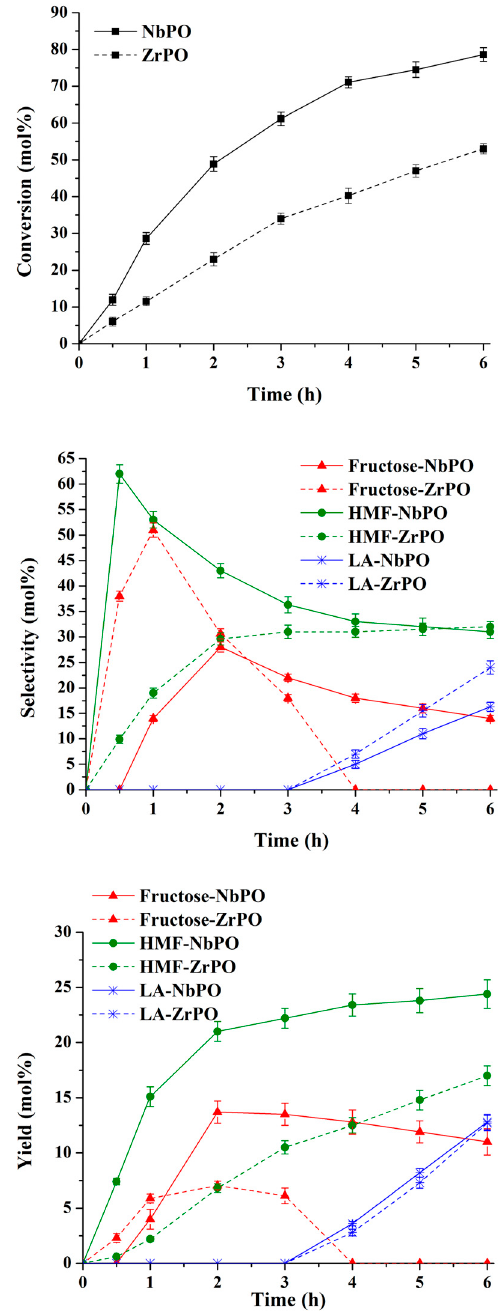
Figure 1. Glucose conversion in the presence of NbPO and ZrPO as acid catalysts in autoclave at 150 °C. Reaction conditions: glucose = 2.47 g; catalyst = 2.06 g; water = 47.0 g; T = 150 °C. Note: where the error bars are not visible, they are smaller than the symbols.